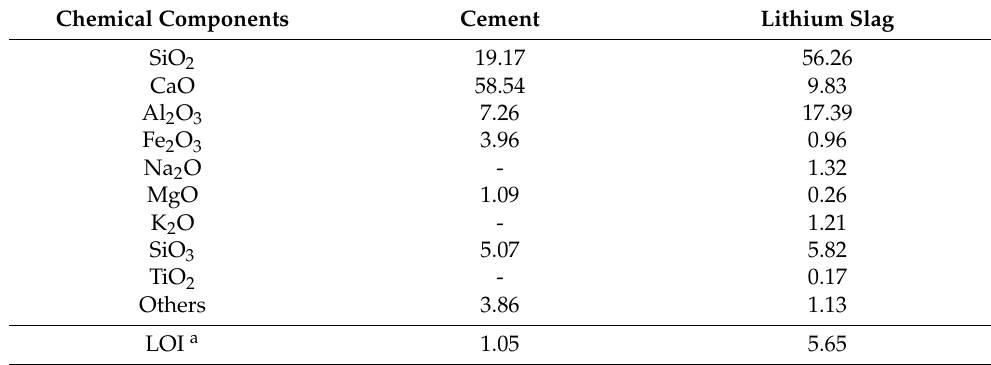
Table 2. Chemical compositions of cement and LS